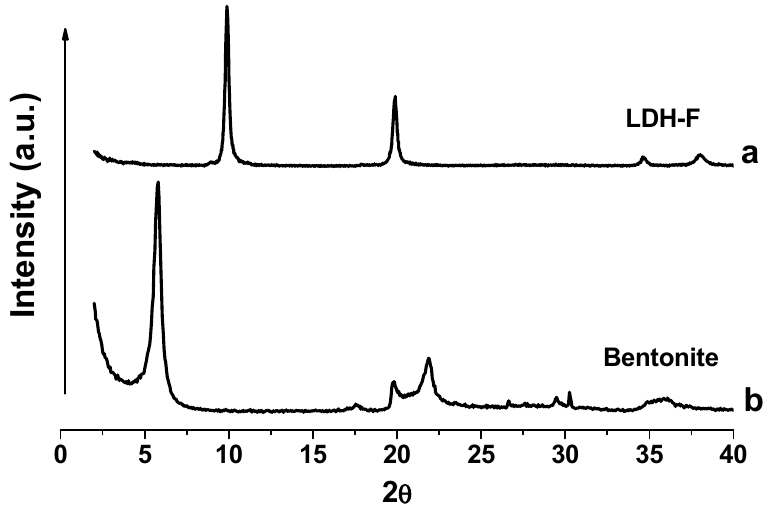
Figure 1. XRD patterns of ( a ) fluoride-intercalated layered double hydroxide (LDH-F) and ( b ) calcium bentonite clay (Bt) powders. The curves are vertically translated for clarity.